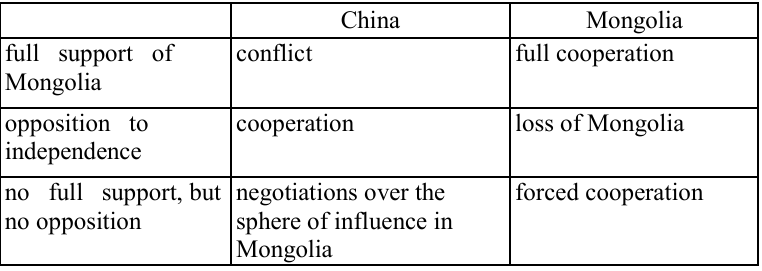
Table of Russian strategy vies a vies